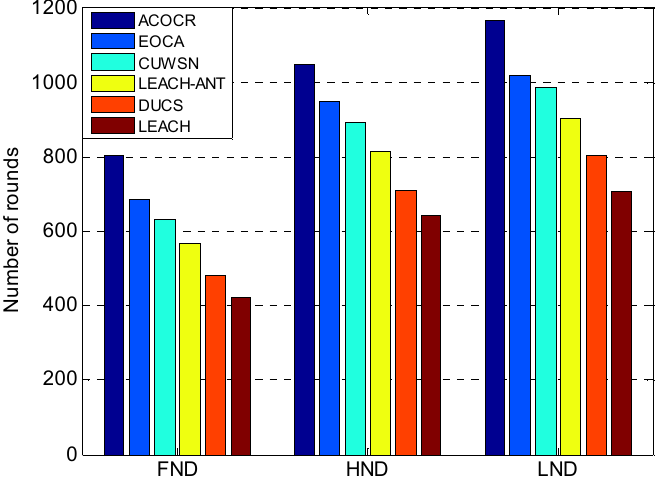
Figure 5. The number of rounds when first node dead (FND), half of the nodes dead (HND), and last node dead (LND) arise for the six algorithms.